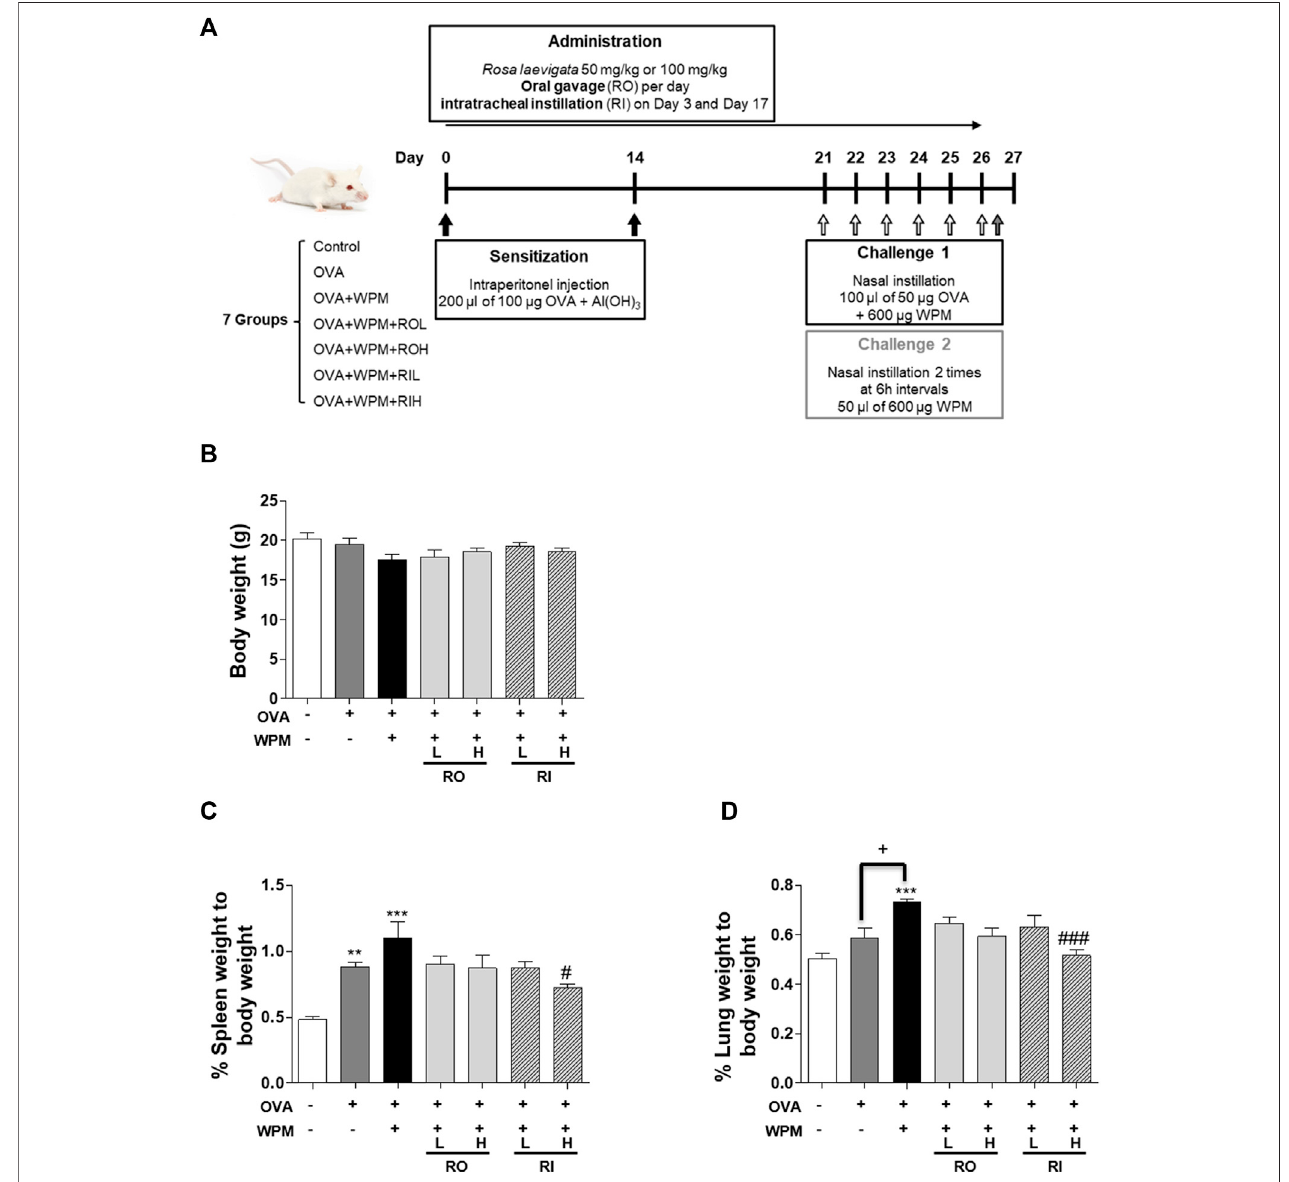
FIGURE1| TheeffectsofRLonorganweightinamouse modelofasthmaexacerbated byWPMexposure. (A) AWPM-exacerbatedmousemodelofasthmaand RL treatment was established. (B – D) The effects of RL on the weights of (B) the body, (C) spleen and (D) lungs of WPM-exacerbated mouse model. All data are presentedasthemean±SEM. n =5/group. ** p < 0.005 and*** p < 0.001 compared withthecontrolgroup; # p < 0.05and ### p < 0.001 compared withtheOVA+WPM group; + p < 0.05 compared with the OVA group.